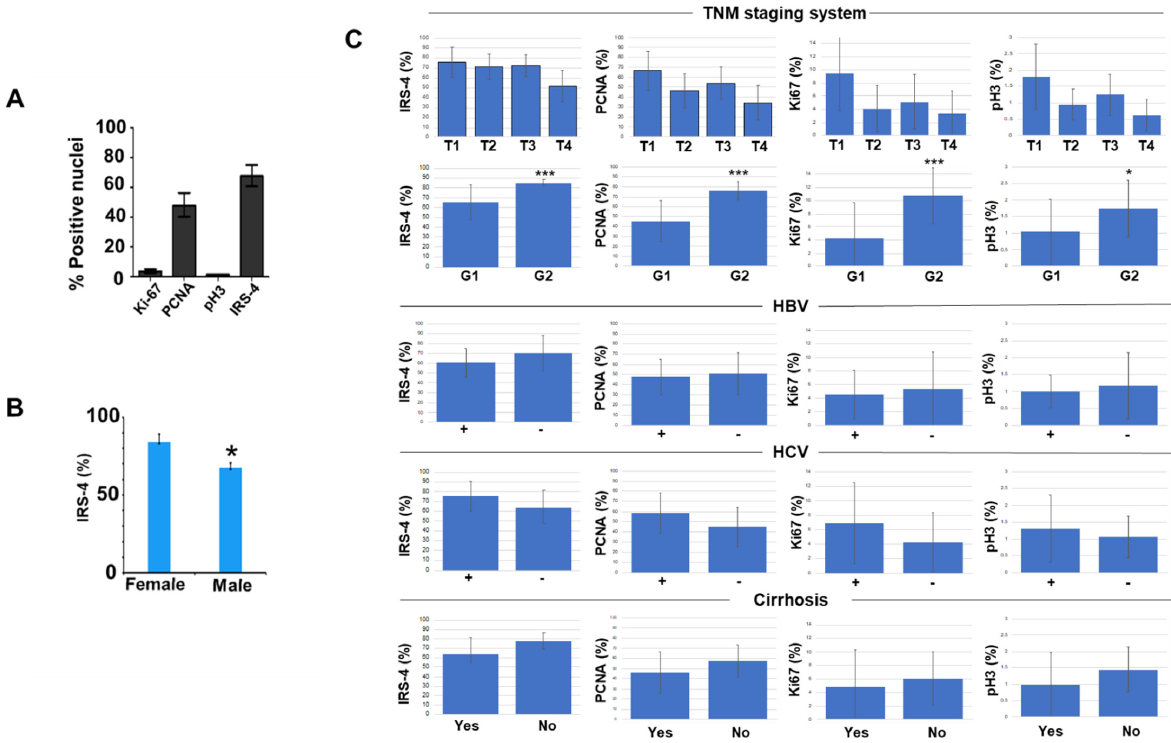
Figure 3 . Bar graphs representing quantitative analysis of immunohistochemical staining. ( A ). Percentage of positive nuclei of IRS-4, PCNA, Ki-67, and pH3. ( B ). Percentage of IRS-4 positive nuclei in female and male samples. ( C ). Percentage of positive nuclei of IRS-4, PCNA, Ki-67, and pH3 compared with notable patient measures. Data are represented as mean and SD. Significance levels using student t test were: * p < 0.05; *** p < 0.001.